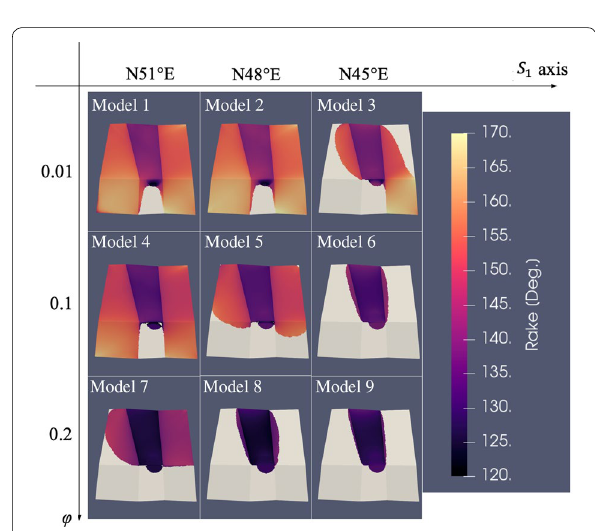
Fig. 12 Final distribution of rake angles for different stress parameters. View from the east. The rake is taken 90° for the reverse fault, 180° for the right-lateral strike-slip